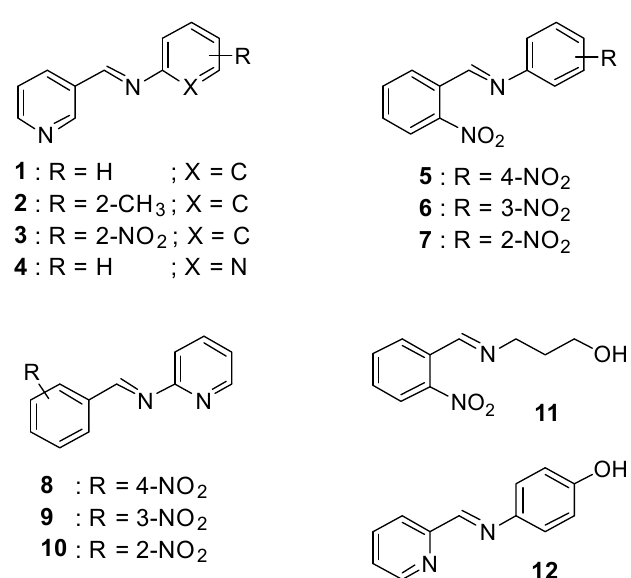
Scheme 1 . General structures of the prepared Schiff base